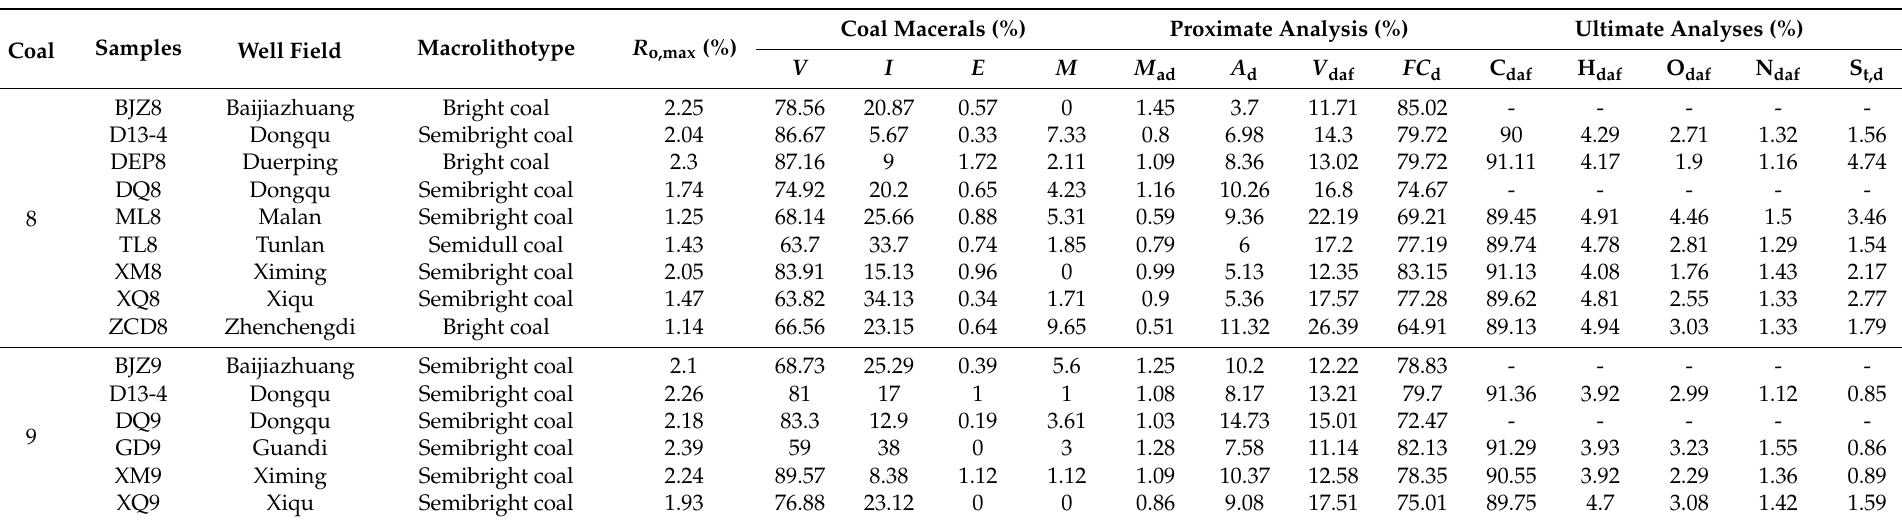
Table 1. Basic features of coal samples in the Gujiao